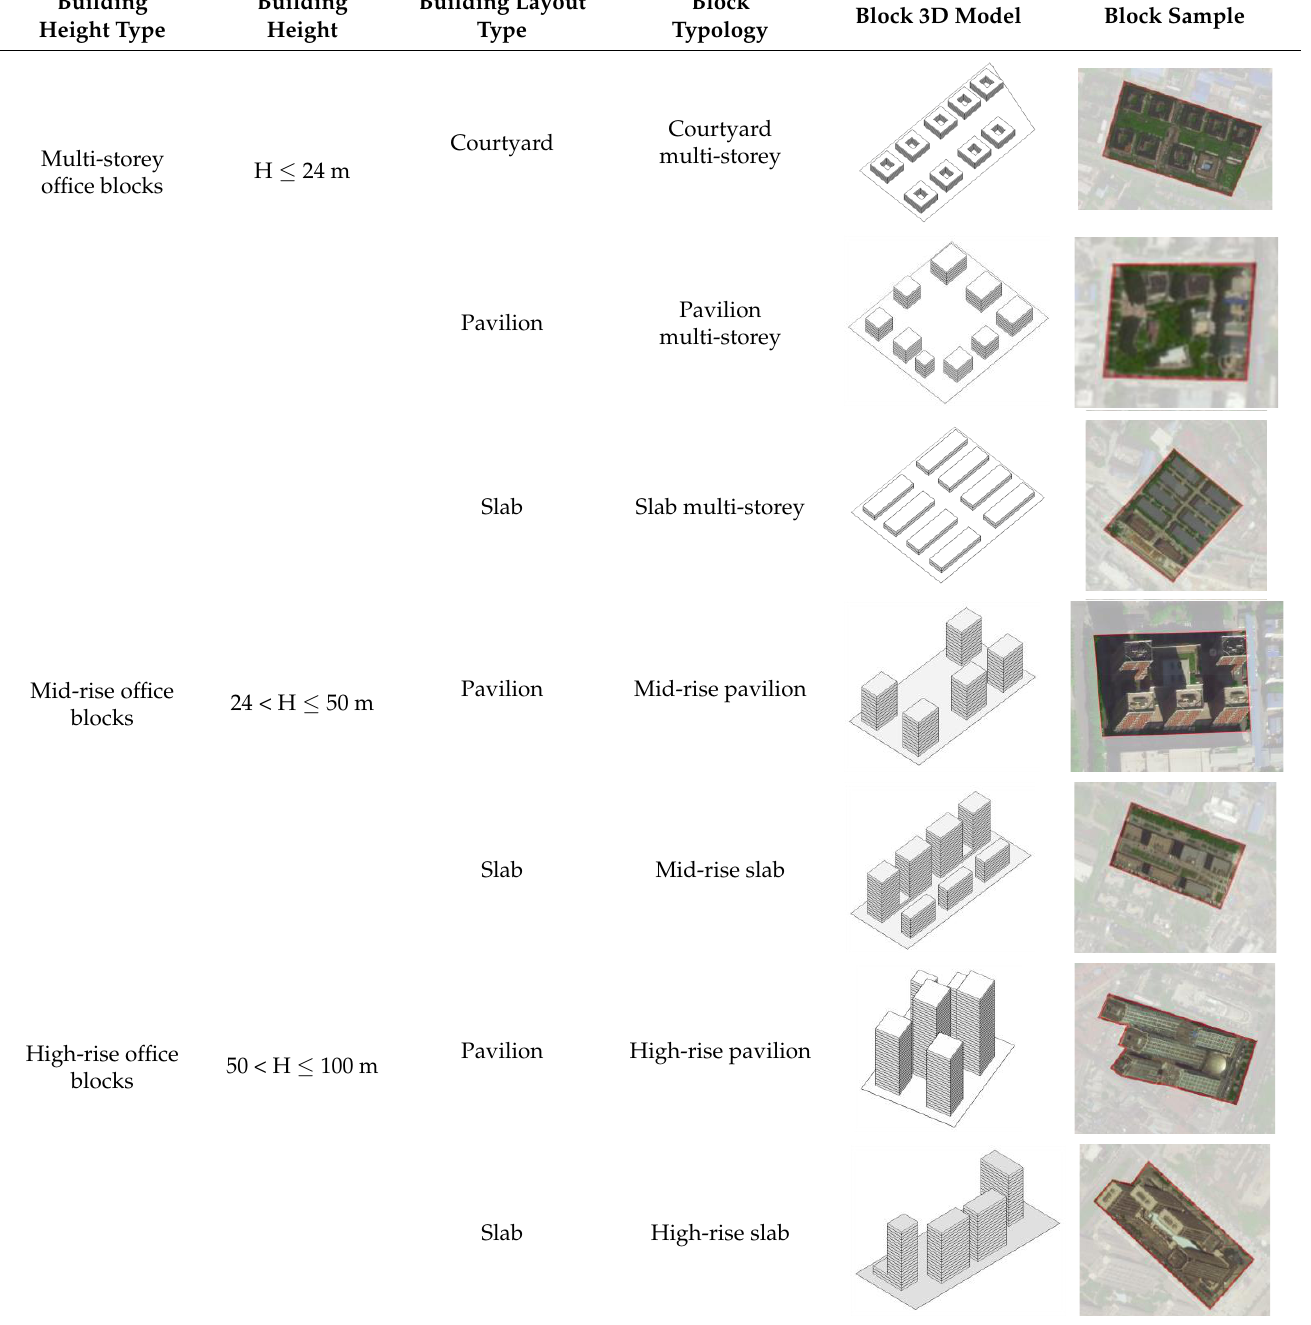
Table 1. The classification results of real office block samples.